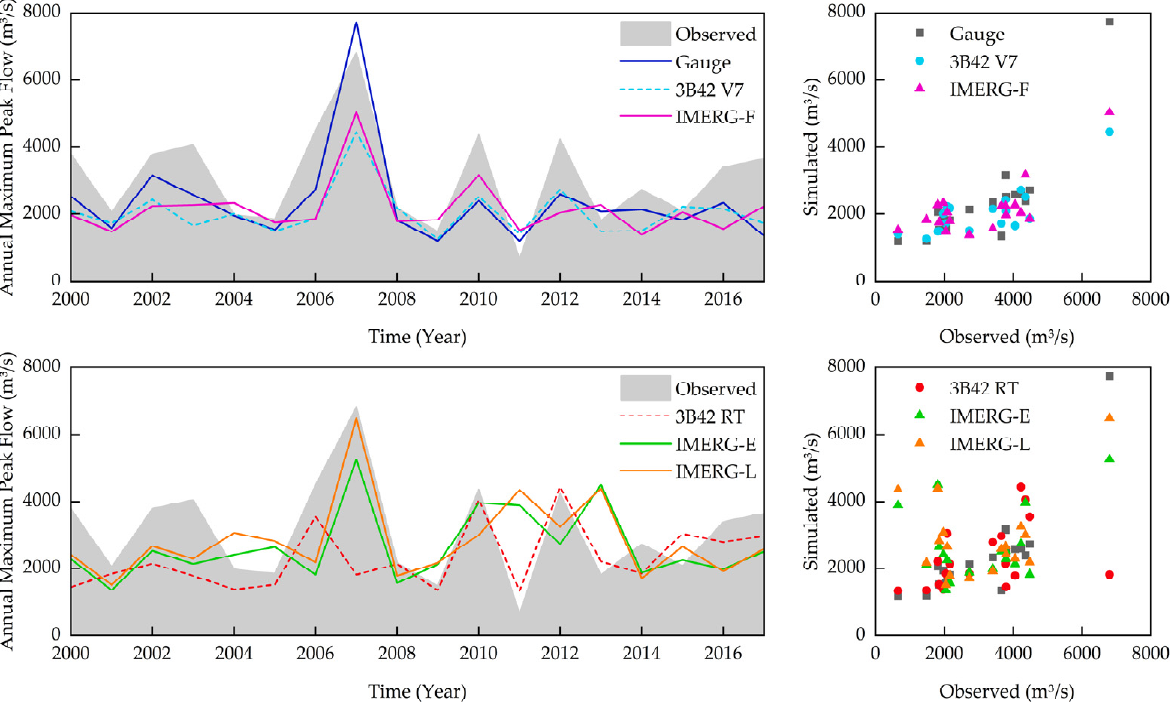
Figure 6. Selected annual peaks from the observed records and the different simulations for the period 2000–2017.